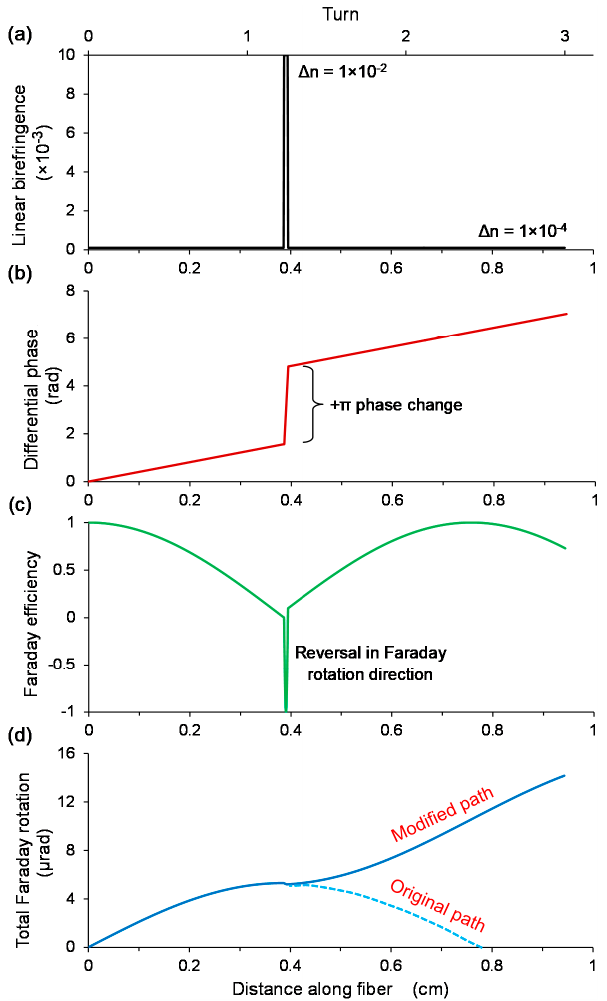
Figure 12. Simulations of birefringence modulation in a microfiber coil to rectify the direction of Faraday rotation for an efficient build-up of sensitivity over fiber length. The impact of changing ( a ) the local birefringence, is reflected in ( b ) the differential phase, ( c ) the Faraday efficiency, and ( d ) the Faraday rotation.